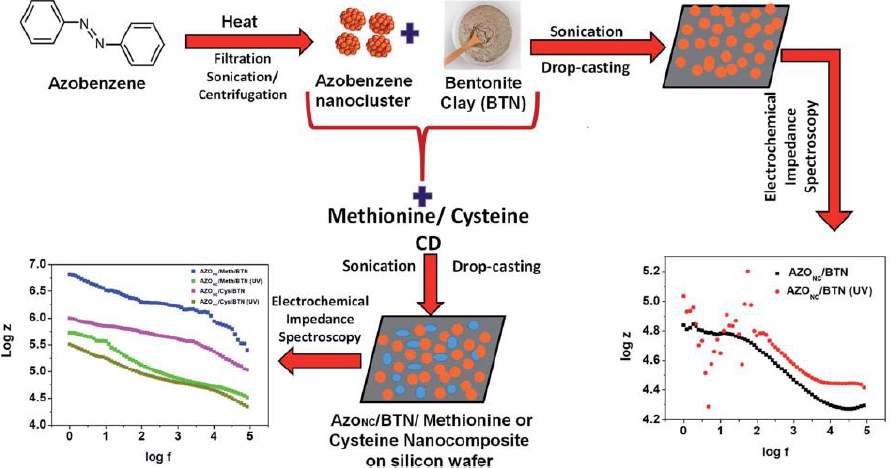
Figure 4. Protocol adopted to develop a photoresponsive carbon-dot-incorporated azobenzene nanocluster–clay (bentonite) hybrid with tunable conductivity (reproduced from ref. [64]; copyright 2020 Royal Society of Chemistry).